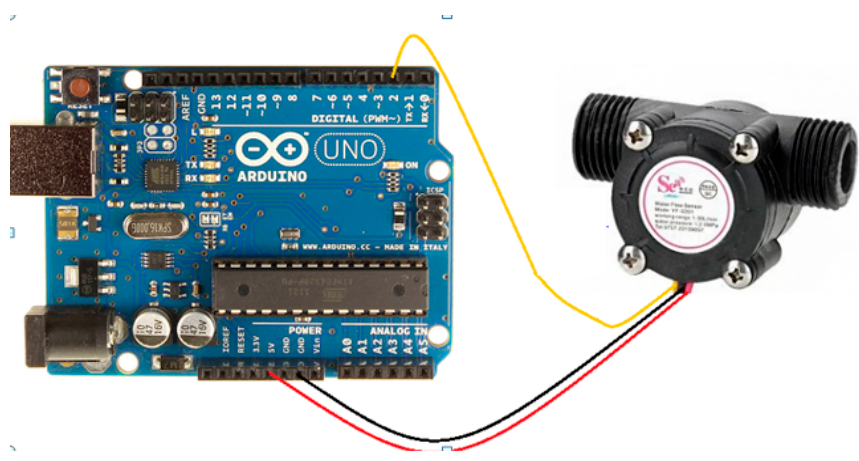
Biology 2021 , 10 , x FOR PEER REVIEW Figure A3. Dust-Sensitive Nose model’s circuit. Figure A3. Dust-Sensitive Nose model’s circuit.